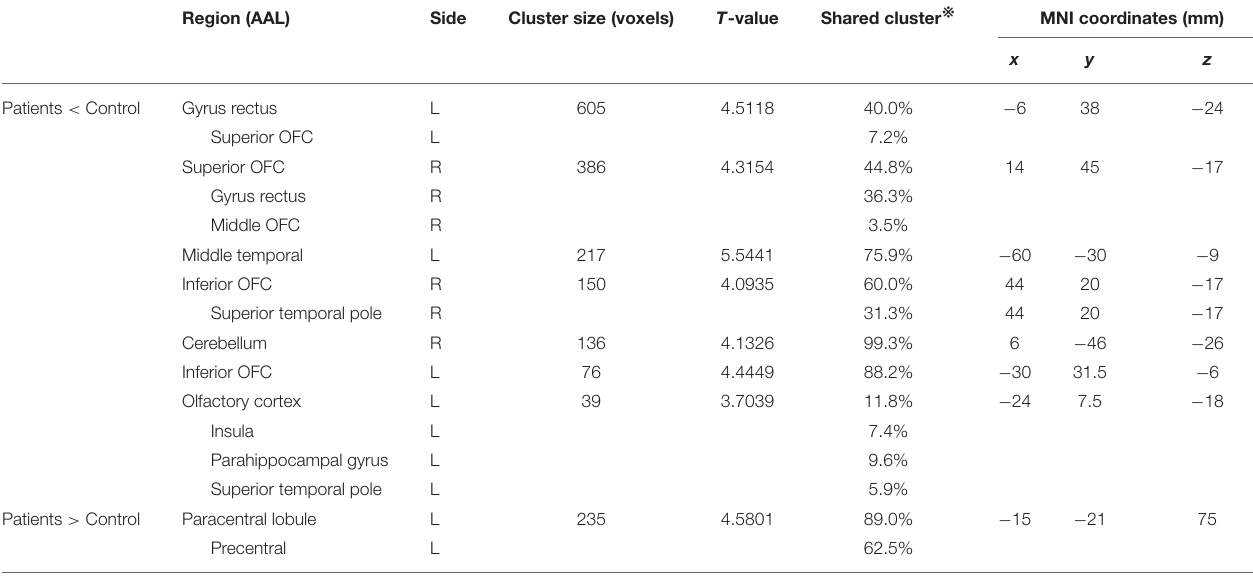
Patients > Control Paracentral lobule Precentral L 62.5%